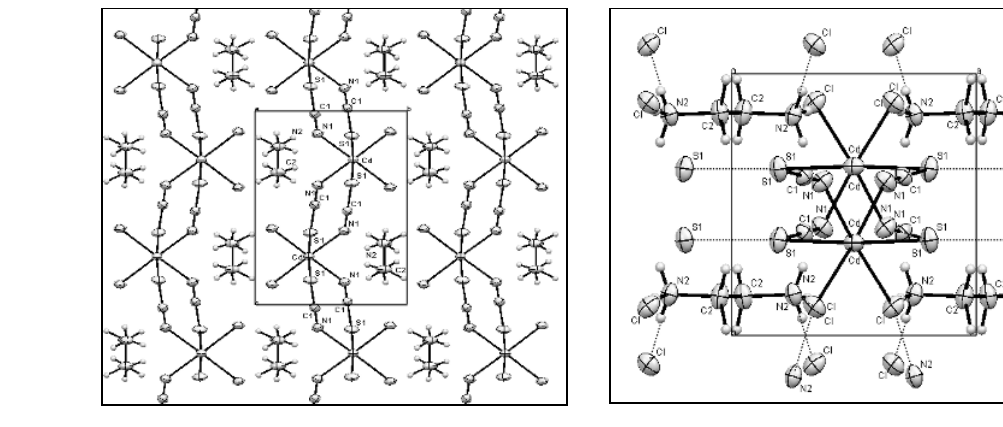
2 H 10 N 2 CdCl 2 (SCN) 2